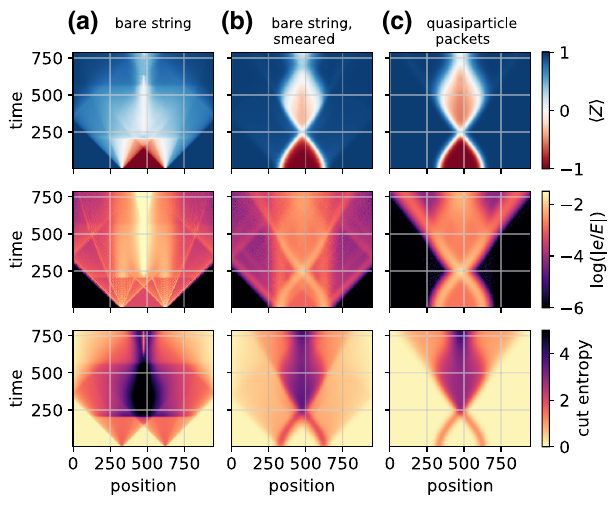
FIG. 22. Evolution of spin and energy density expectation values and the cut entropy for parameter set (ii) of the main text ( λ = 0.41, g = 0.98, h = 0.001), with three different initial states. State (a) is prepared by acting on the vacuum with a string (cid:11) x R − 1 operator X j , which flips the spins to form a bubblelike j = x L state with energy E / m μ = 8.69. State (b) is similar to (a), but with the ends of the string smeared out using Gaussian packets of width σ = 40, reducing the energy to E / m μ = 4.02. State (c) is the initial state discussed in the main text with E / m μ = 2.62, using quasiparticle wavepackets for the kinks and the false vac- uum for the middle region. The evolution parameters are the same in all cases: the maximum bond dimension is 64 and the RK4 step size is approximately 0.08 (0.05 in unscaled lattice Hamiltonian units). In (a), dramatic errors in the simulation occur at t ≈ 240, indicating the difficulty of simulating these dynam- ics versus (b) and (c). In both (a) and (b), ballistic energy